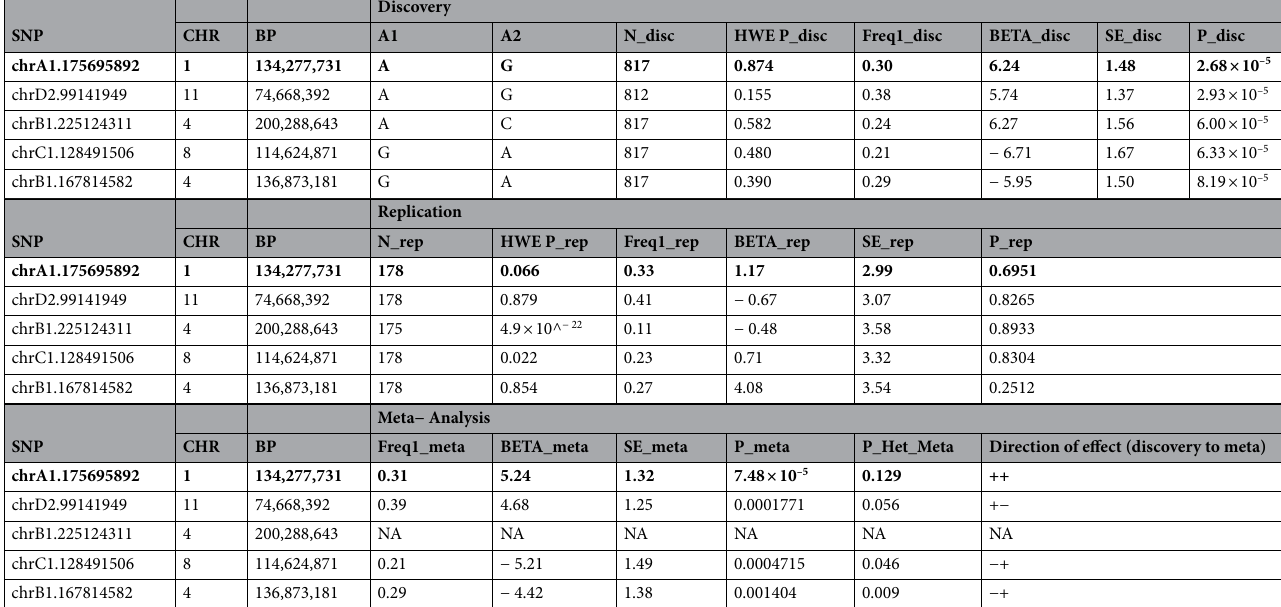
Table 4. Comparison of discovery, replication and meta-analysis for systolic blood pressure. SNP; single nucleotide polymorphism (Named from Illumina Feline Infinium Array), CHR; chromosome (FelCat5; Felis_catus-6.2 Genome assembly), BP; base pairs (FelCat5; Felis_catus-6.2 Genome assembly), A1; minor allele, A2; major allele, n; number, HWE; Hardy Weinberg Equilibrium, disc; discovery cohort, rep; replication cohort, meta; meta-analysis, freq1; frequency of minor allele, SE; standard error, p ; significance. Bold indicates experimental wide significance for meta-analysis ( P < 1 × 10 –6 ) and/or concordance of direction of